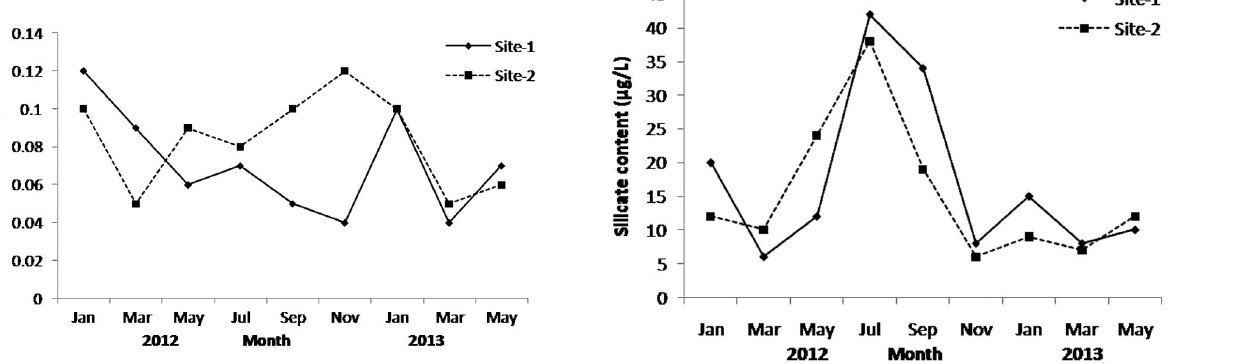
Fig. 7. – Seasonal variations in nitrite content of seawater at Site 1, Payyannur (PNR) and Site 2, Panambur (PNBR).